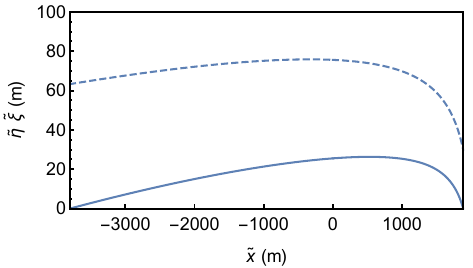
Figure 6. The distributions of non-normalized bed elevation and water surface over one step wave- length, in the lower